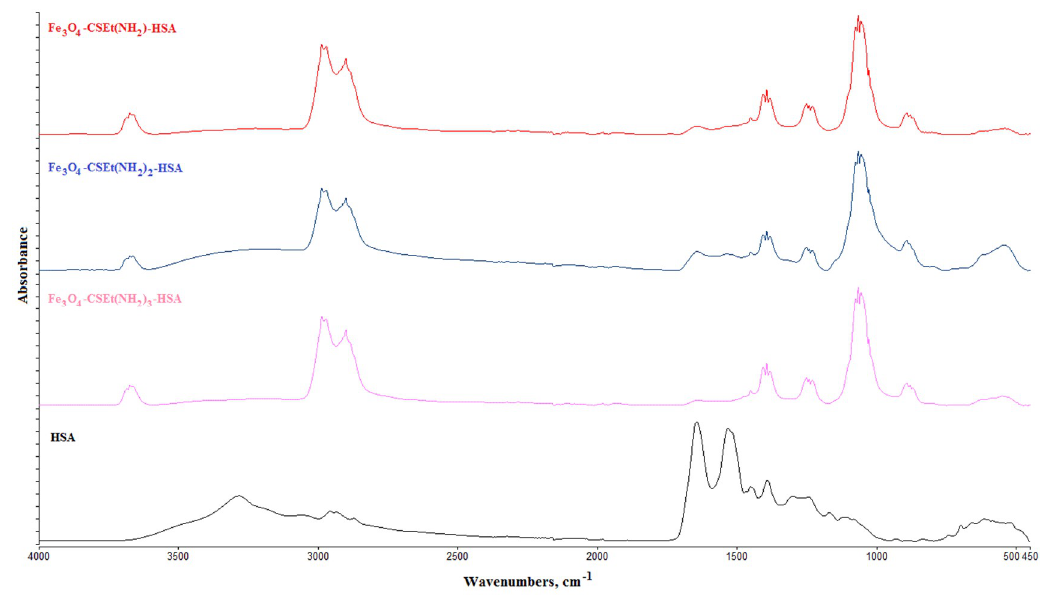
Figure 8. ATR-FT IR results for human serum albumin (HSA)-coated nanoparticles .